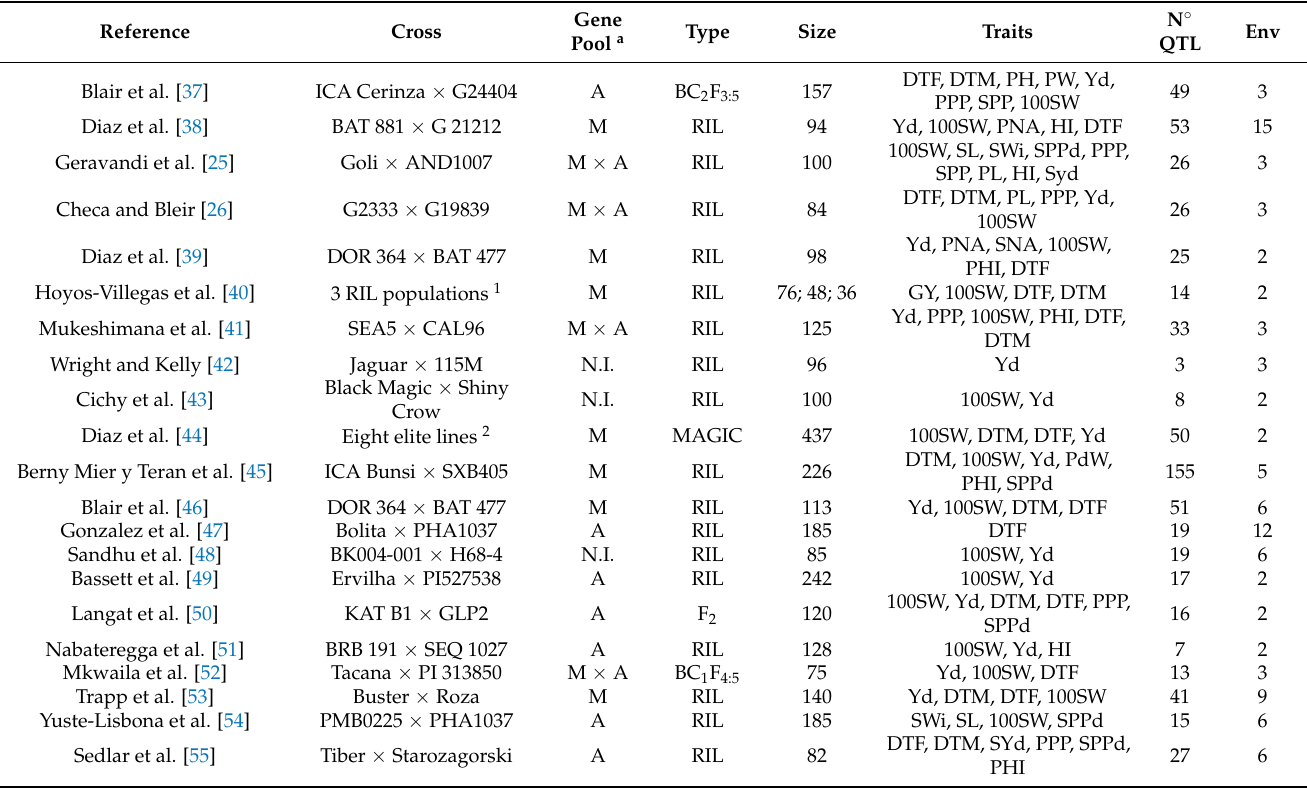
Table 1. Summary of the QTL studies reviewed, including the reference, parental cross, gene pool, type of population, size, traits, number of QTL collected, and the number of environments evaluated in each